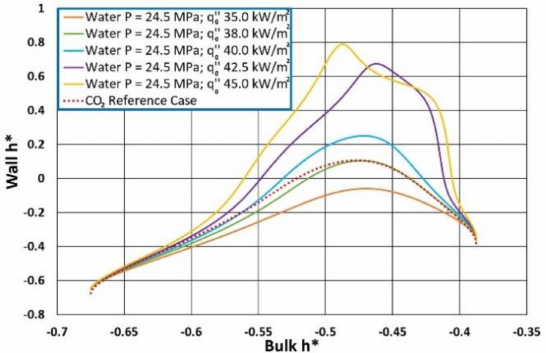
Figure 13. Wall h* trends for water at 24.50 MPa for a reference case with CO 2 , q 0 (cid:48)(cid:48) = 10 kW/m 2 and T in = 24 ◦